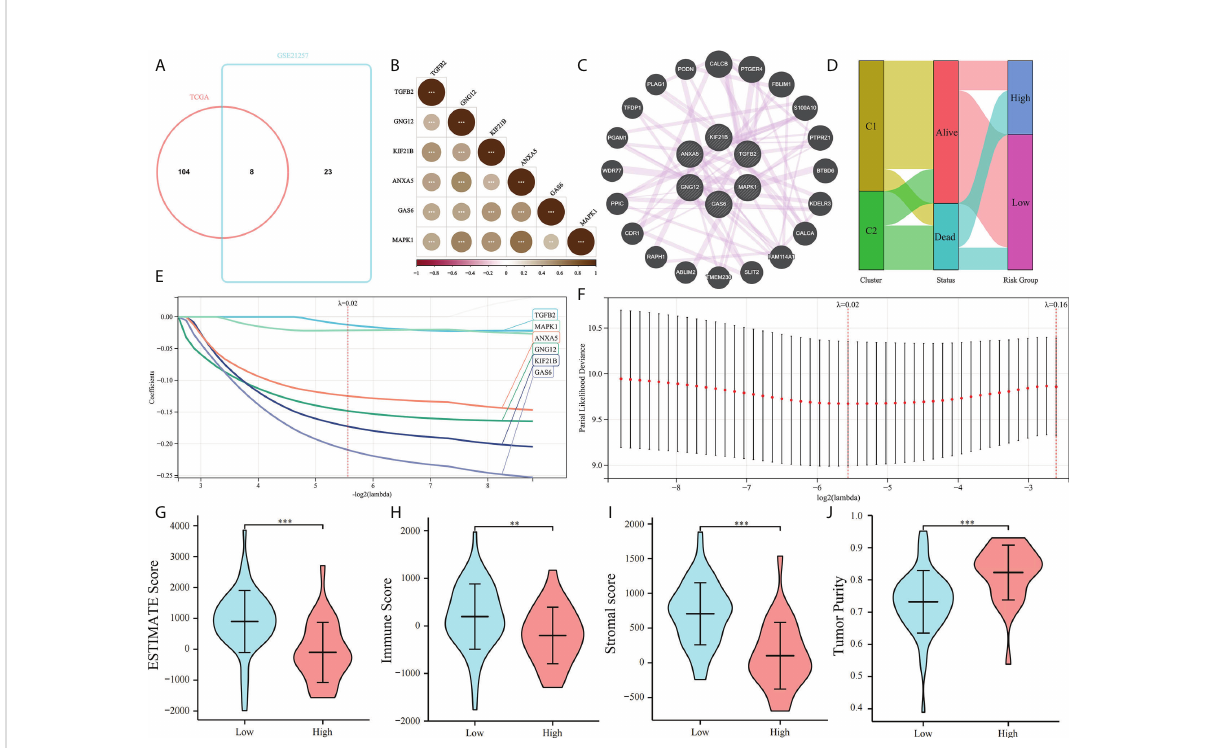
FIGURE 5 Construction of platelet characteristic score model. (A) Venn map screening of platelet related genes associated with prognosis in both TCGA and GSE21257 cohorts; (B, C) Platelet characteristic score model composed of six candidate genes screened using the LASSO analysis with minimal lambda; (D) Heatmap of correlation among six candidate genes; (E) The co-expression relationship of six candidate genes explored by Genemania; (F) Sanggi diagram showing the relationship between subtype, survival status, and platelet score; and (G – J) ESTIMATE Score, Immune Score, Stromal Score, and Tumor Purity of a high-platelet group and low-platelet score groups. **p < 0.01, ***p <